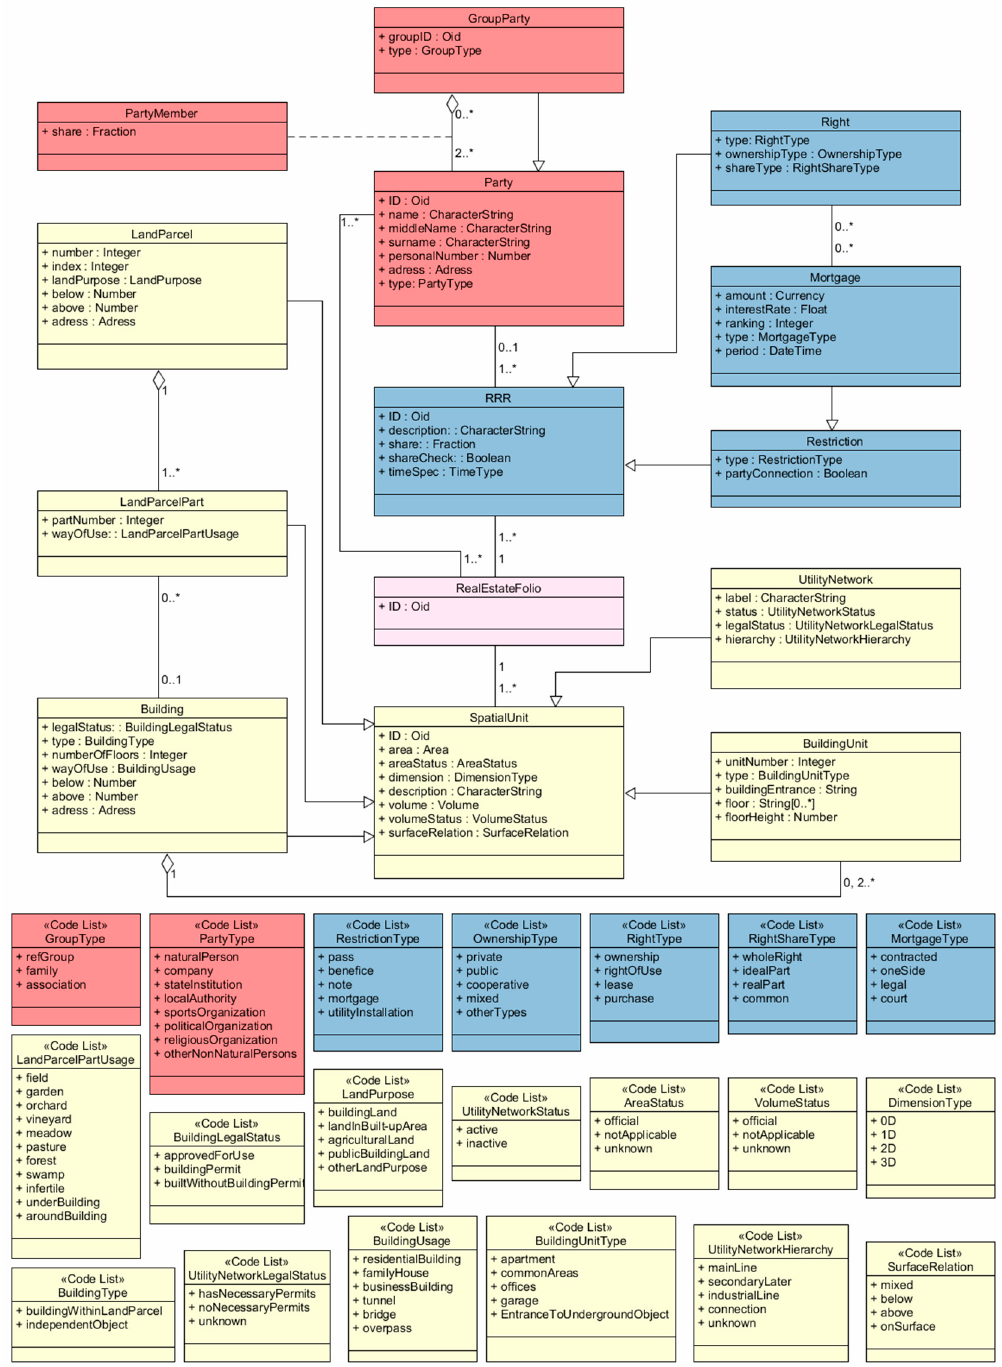
Figure 2. The main classes of the 3D real estate cadastre data model.